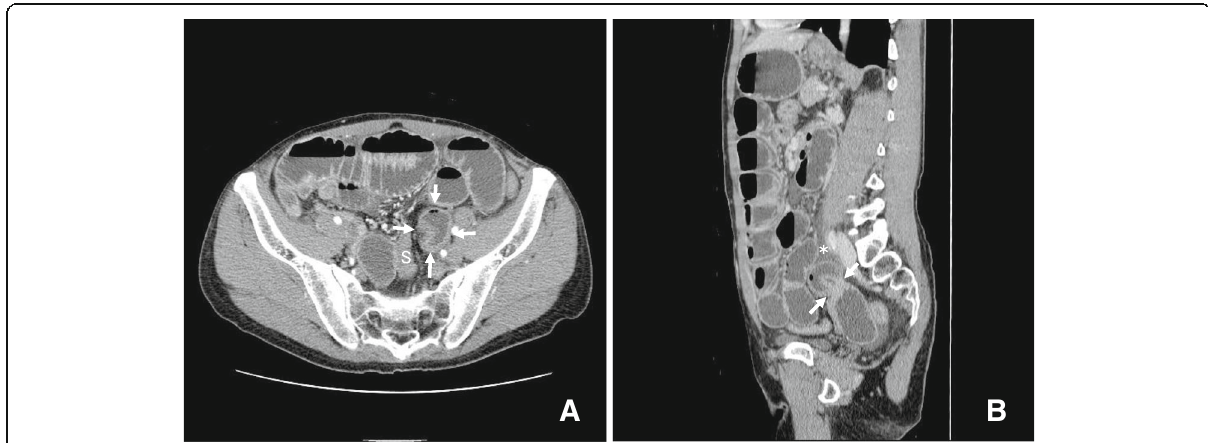
Fig. 1 a MDCT showed small bowel obstruction and an incarcerated short loop of the intestine in the left pelvic space (arrows) on the left side of the collapsed sigmoid colon. S sigmoid colon. b Routine sagittal slices of MPR images showed two closely arranged portions of constriction (arrows) and the incarcerated section of the ileum. Narrow belt-shaped fluid retention (asterisk) was found to contact the incarcerated short loop toward the cranial direction, alongside the psoas muscle, indicating that the fluid and the incarcerated small bowel were wrapped together in the mesosigmoid, which was characteristic of